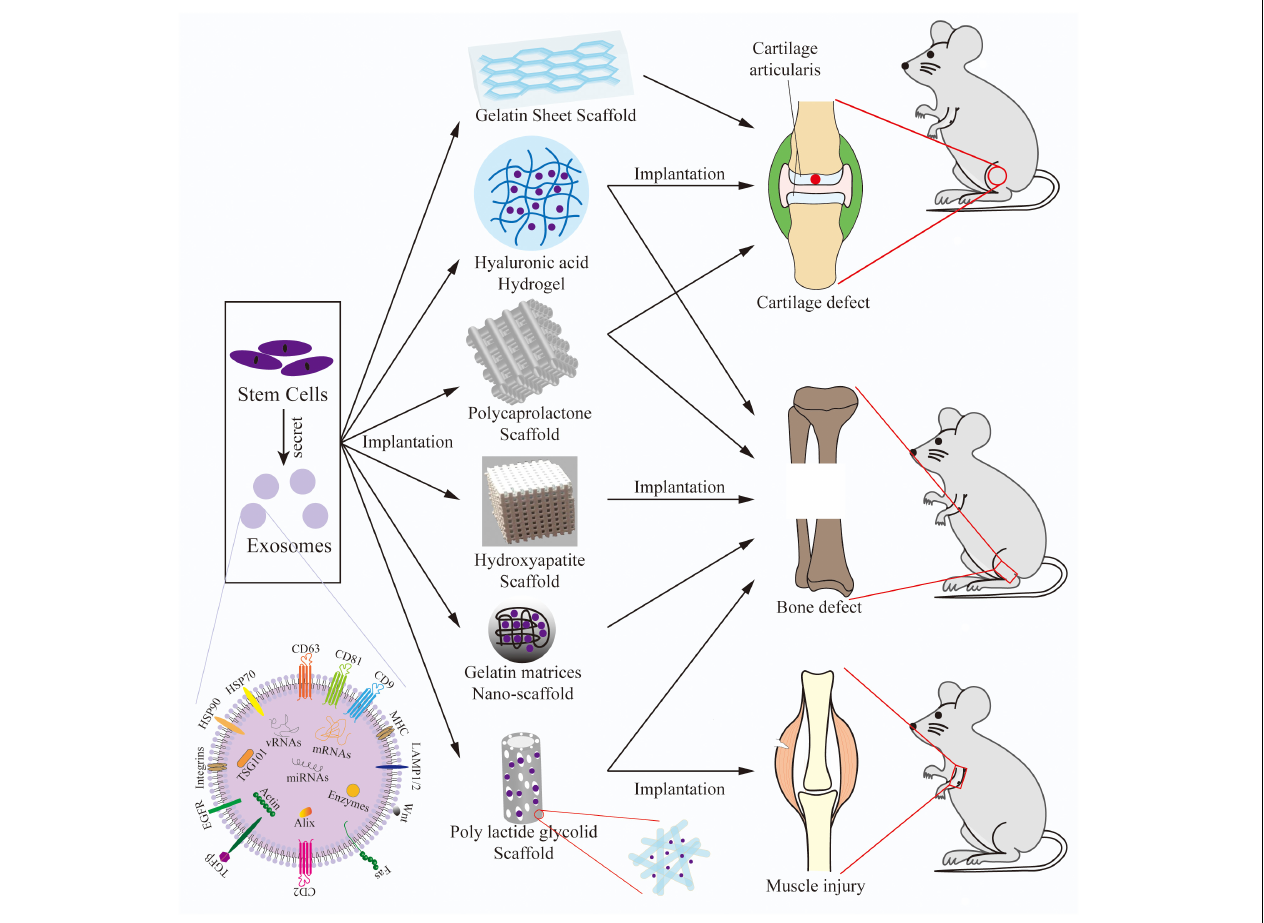
FIGURE 1 | A schematic of the main types of 3D bioprinting. The application process of a 3D scaffold combined with SCs/exosomes implanted into bone diseases. A structural diagram of a representative exosome. SCs/exosomes are implanted in/on the 3D scaffolds, then the composite scaffolds are implanted into models of cartilage defects, bone defects, and muscle